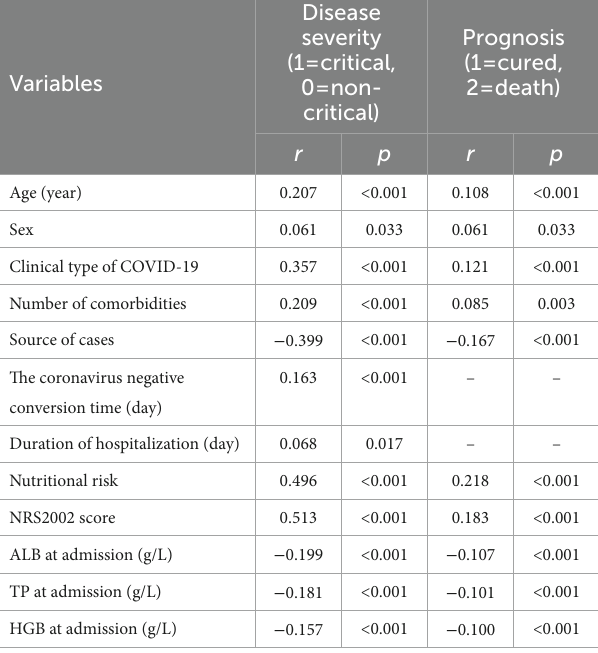
TABLE 4 Spearman’s partial correlation analysis between nutritional parameters, nutritional risk, NRS2002 score and the disease severity and prognosis after controlling for age and number of comorbidities ( n = 1,228).